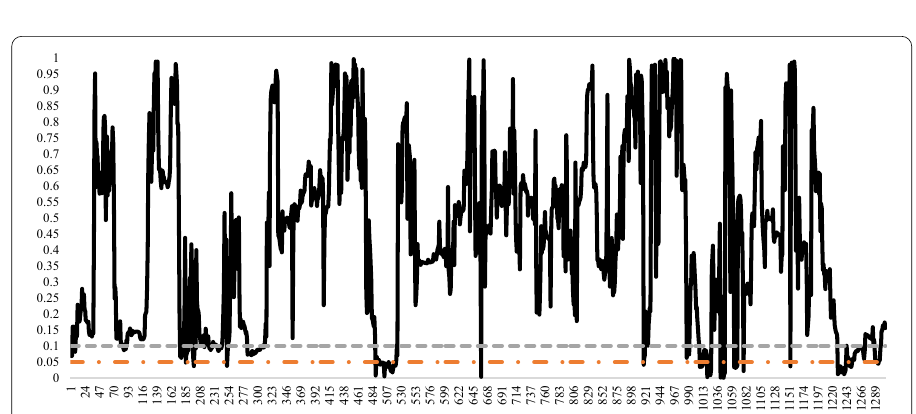
Fig. 11 The evolving p values of the AQ test statistic checked for the Ripple (XRP) in 50-day window length